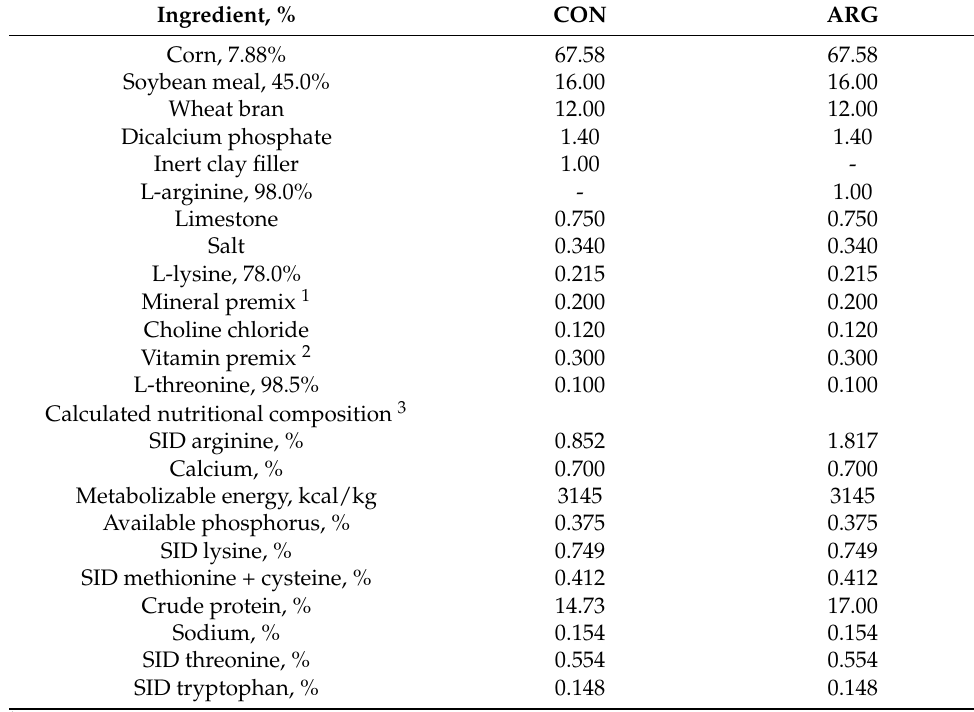
Table 1. Composition of experimental